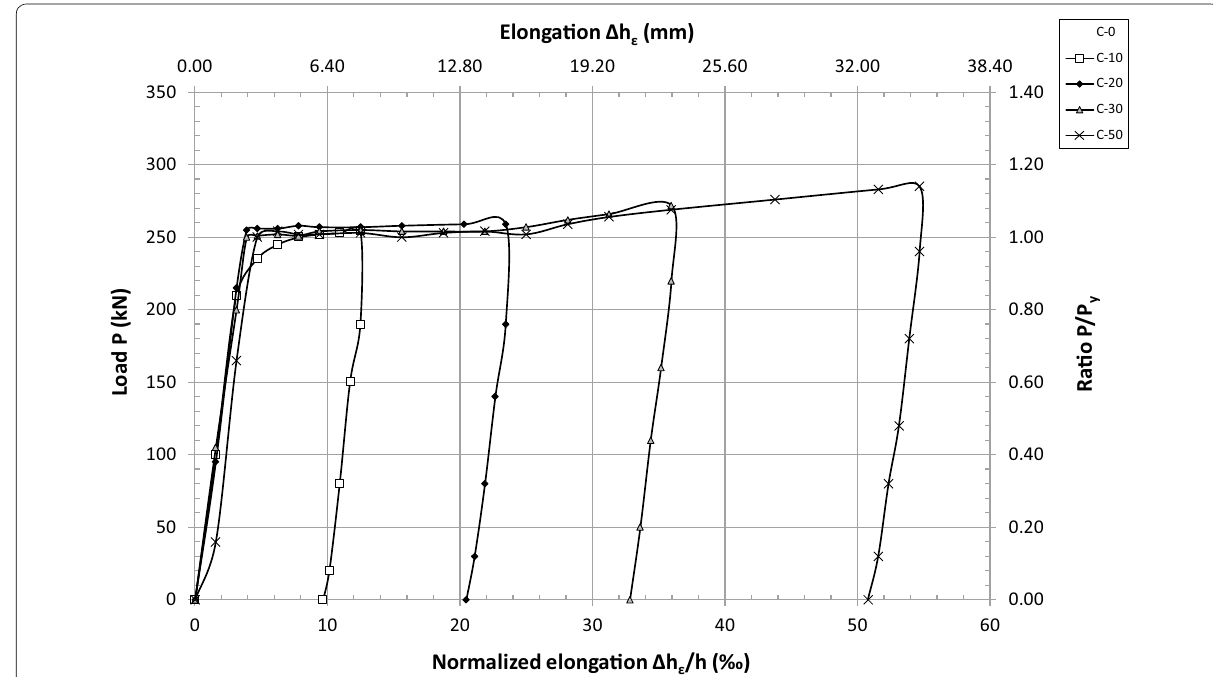
Fig. 6 Variation of tensile load relative to elongation.